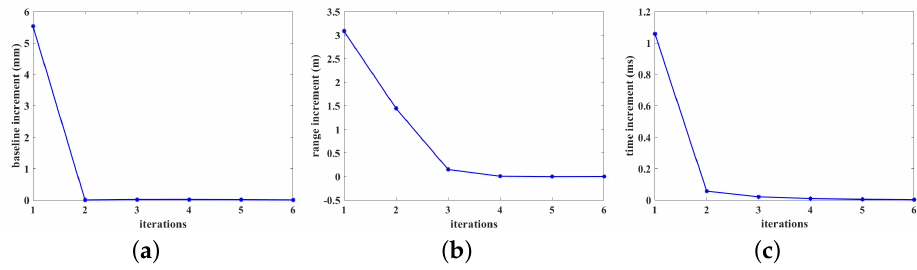
Figure 10. Convergence curves of ( a ) spacial basline, ( b ) slant range, and ( c ) timing